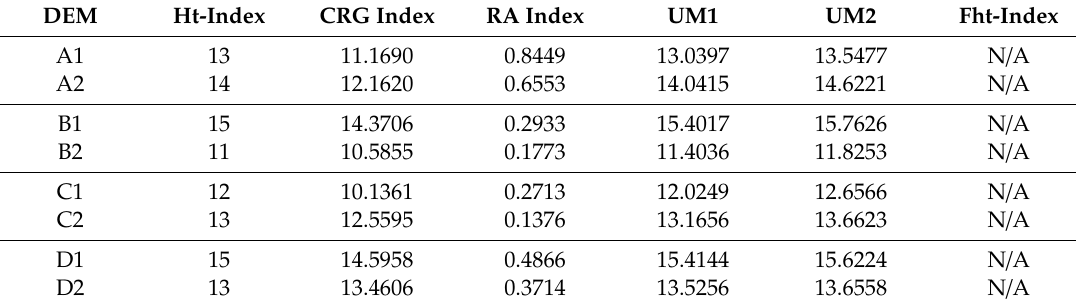
Table 4. Fractal metrics of the digital elevation models (DEMs) for